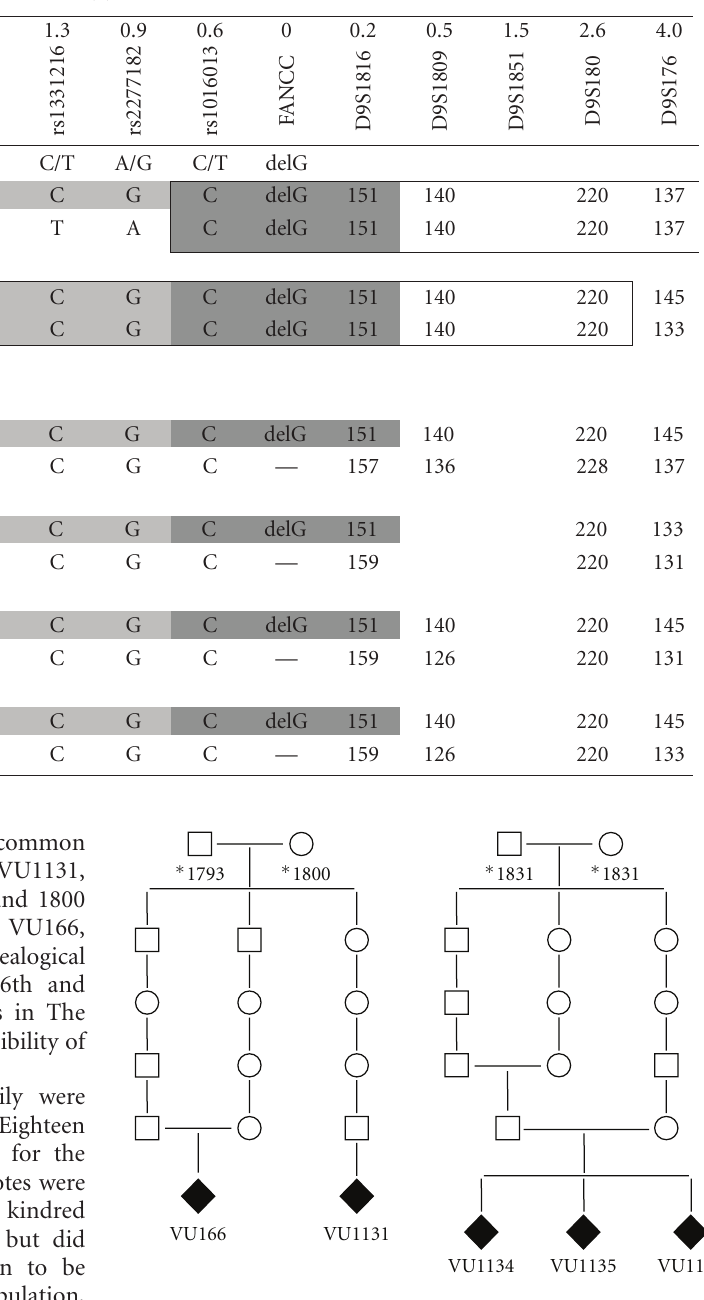
Figure 1: Pedigrees showing consanguinity for patients VU166 and VU1134/35/36. Common ancestors of patients VU166 and VU1131 were found living around 1800. ∗ year of